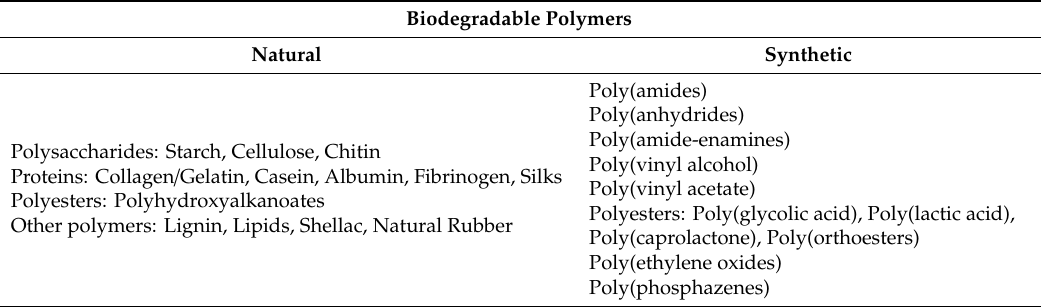
Table 1. Biodegradable polymer matrices (adapted and developed from